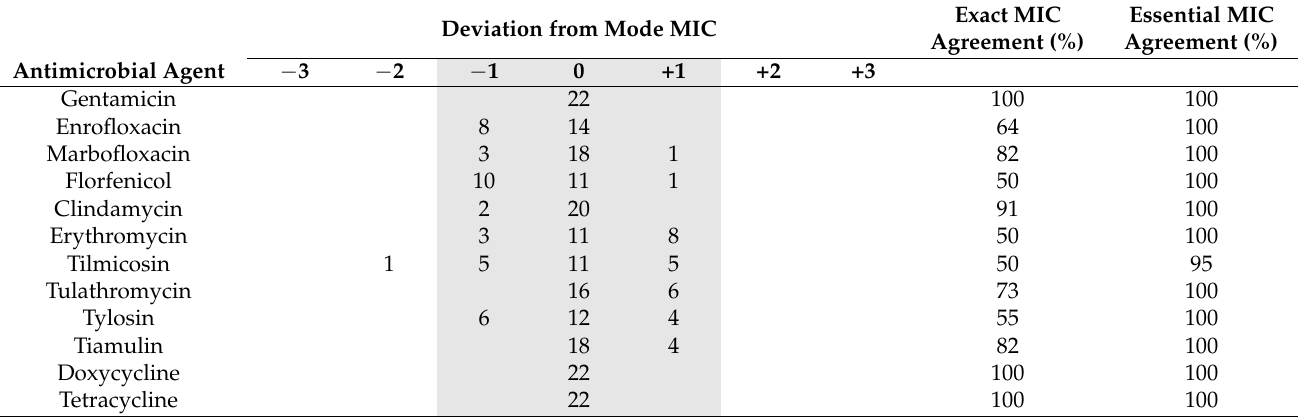
Table 3. Homogeneity of the MIC values of the 22 test replicates of M. hyorhinis DSM 25591, as given in Table 2. The grey shaded area describes the MIC values accounting for the essential MIC agreement.